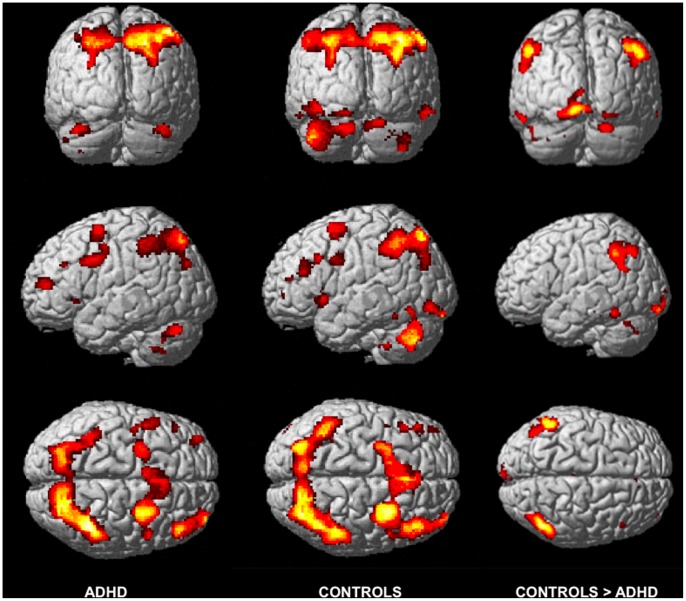
Working memory-related common and specific neural activity patterns in ADHD.Left column: WM-related activation (N2> N0) in ADHD children. Middle column: WM-related activation (N2> N0) in Control children. Right column: higher WM activation (N2> N0) in Control than in ADHD children (interaction effect). All effects are displayed at punc <0.001, superimposed on the ICBM standardized anatomical template.